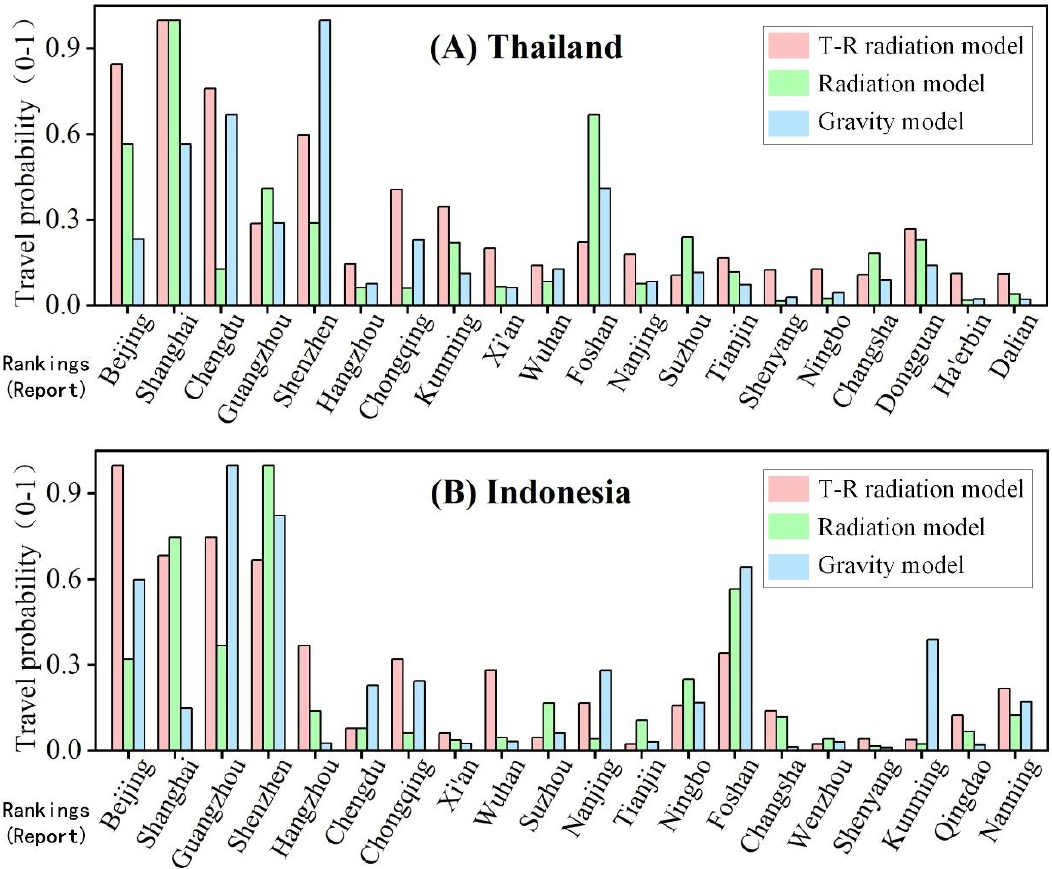
Figure 8. Travel probability estimation results by temporal-range (T-R) radiation model, radiation model (spatial-range), and gravity model from China to ( A ) Thailand and ( B ) Indonesia. Top 20 cities and rankings on the x -axis are from the “2019 big data report on outbound tourism”.